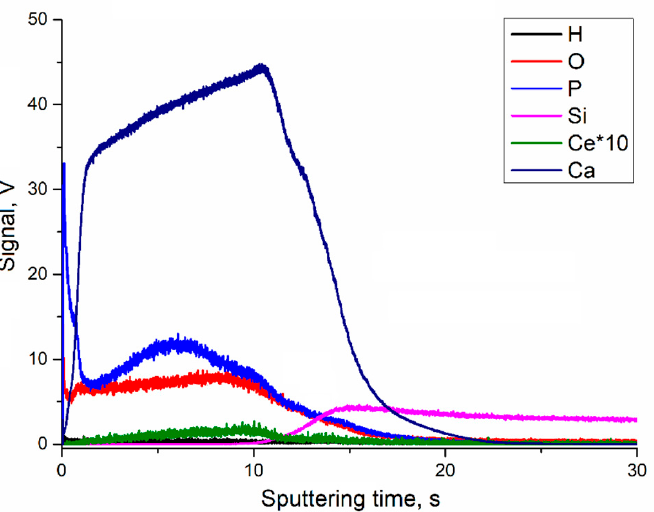
Figure 8. Compositional depth profiles of the 10Ce-HAp coating obtained by glow discharge optical emission spectroscopy (GDOES).